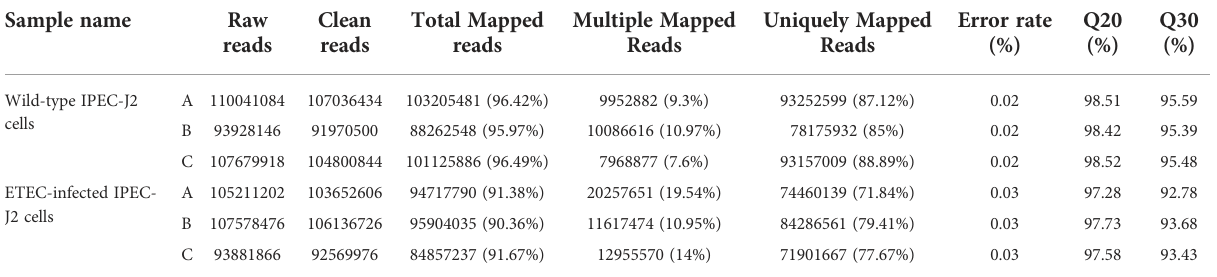
TABLE 1 The RNA-seq quality